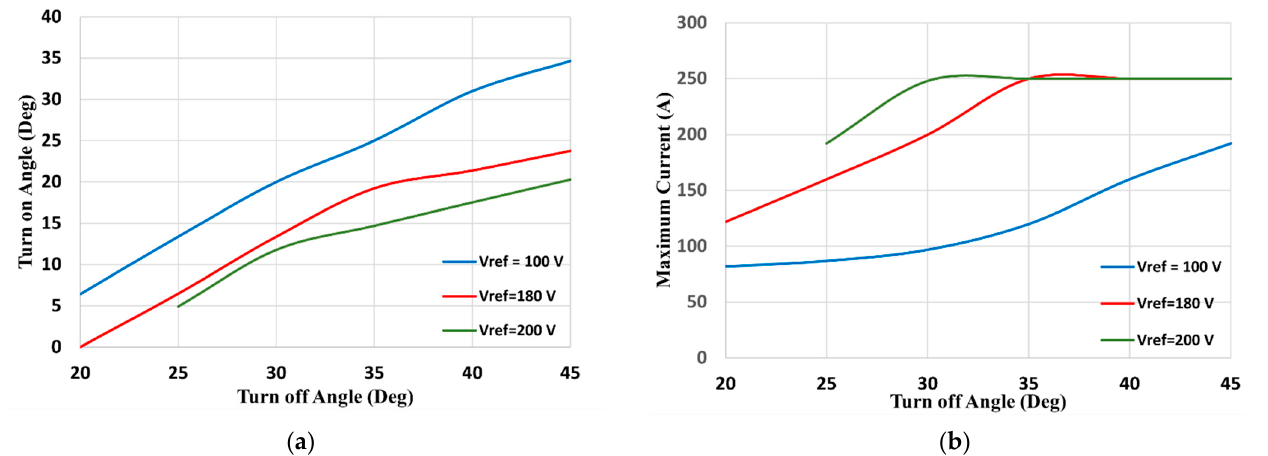
Figure 11. The effect of the initial turn-off angle on ( a ) the generated turn-on angle and ( b ) the maximum generated current at different reference output voltages.